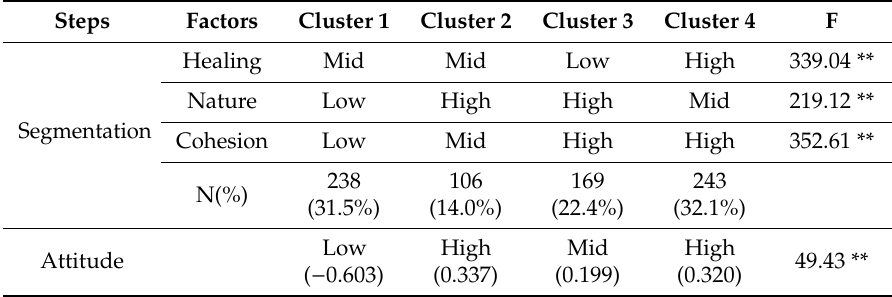
Table 5. Responsible attitude comparison of the clusters.